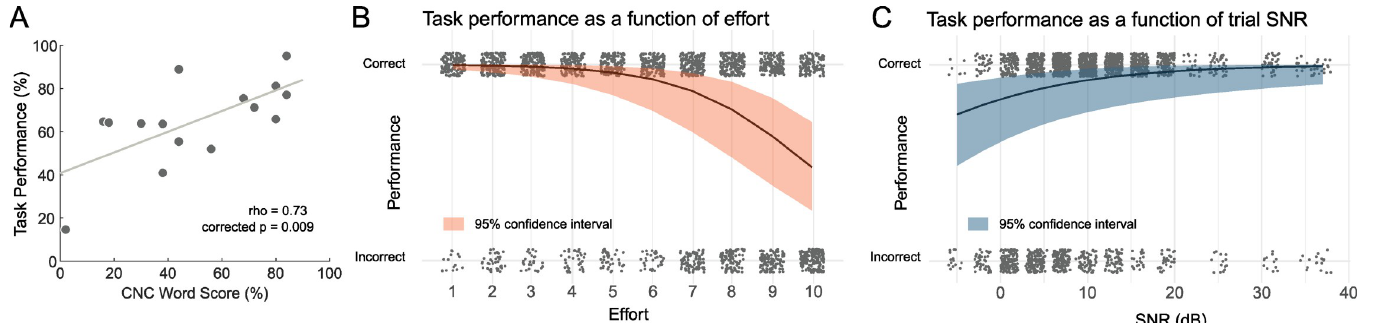
Fig 2. Behavioural data. A) Correlation between CNC Word Score (a clinical test of word recognition) and performance on the task. The line represents the least squares fit. “Rho” indicates Spearman’s correlation coefficient. B) Performance predictions from the logistic mixed effects model plotted against individual trials (grey dots). Note that dots are randomly jittered around each effort level and performance outcome for visibility. The fitted line represents model predictions of performance from subjective effort, with the orange shaded region bounding the 95% confidence interval. C) The same as panel B, but plotting performance as a function of SNR.